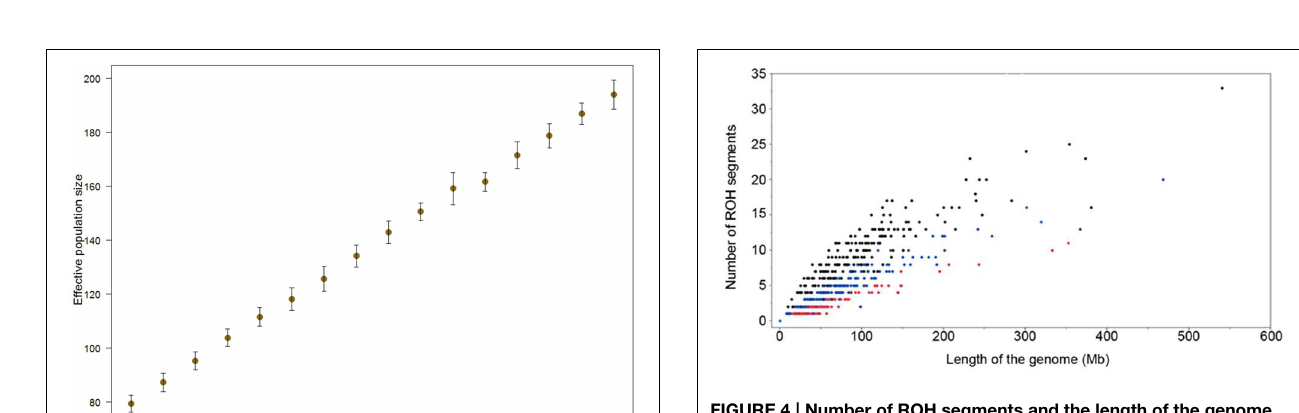
FIGURE 4 | Number of ROH segments and the length of the genome covered by ROH segments (minimum ROH length set to 4Mb in black, 8Mb in blue and 16Mb in